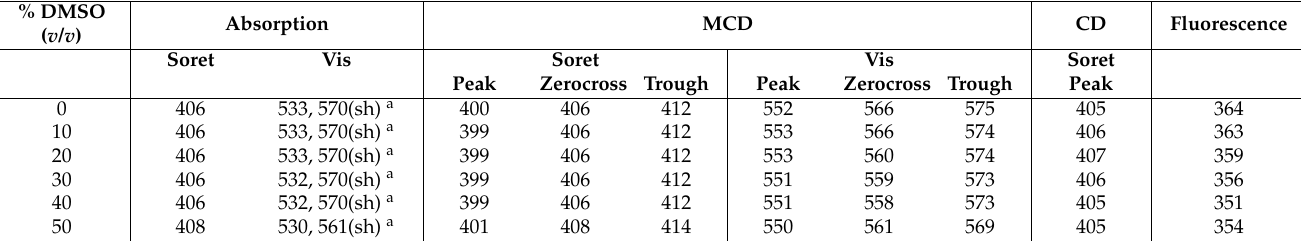
Table 3. Wavelengths (nm) of the relevant spectral features of the UV-vis, MCD, CD and fluorescence emission spectra for the M80A variant of Saccharomyces cerevisiae iso-1 cytochrome c in 10 mM phosphate buffer pH 7, in the presence of increasing concentrations of